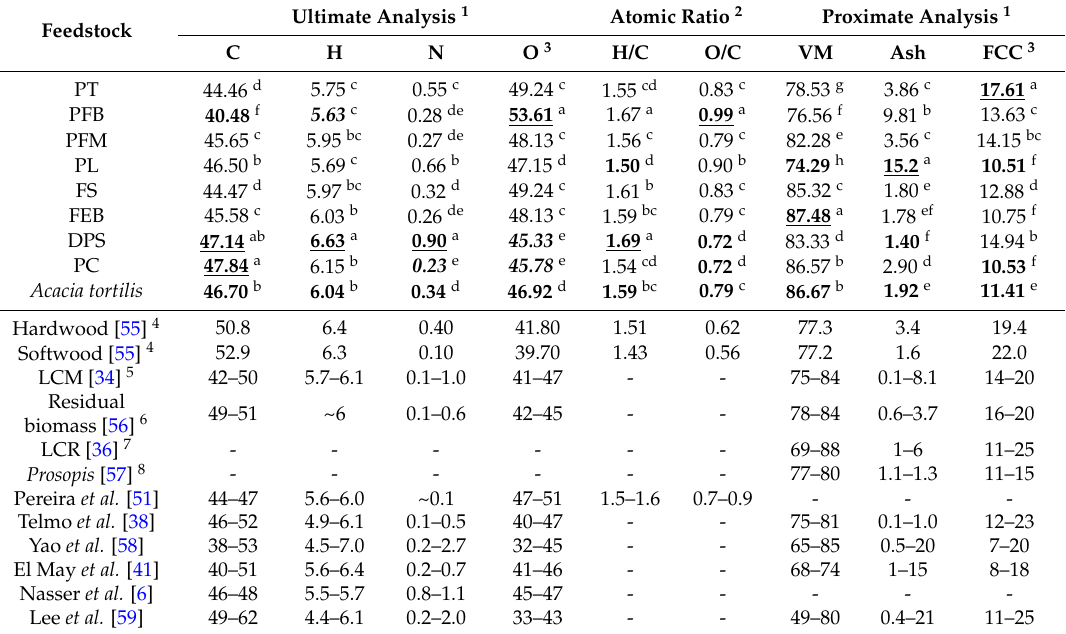
Table 3. Ultimate and proximate analyses of the Sukkari date palm residues.